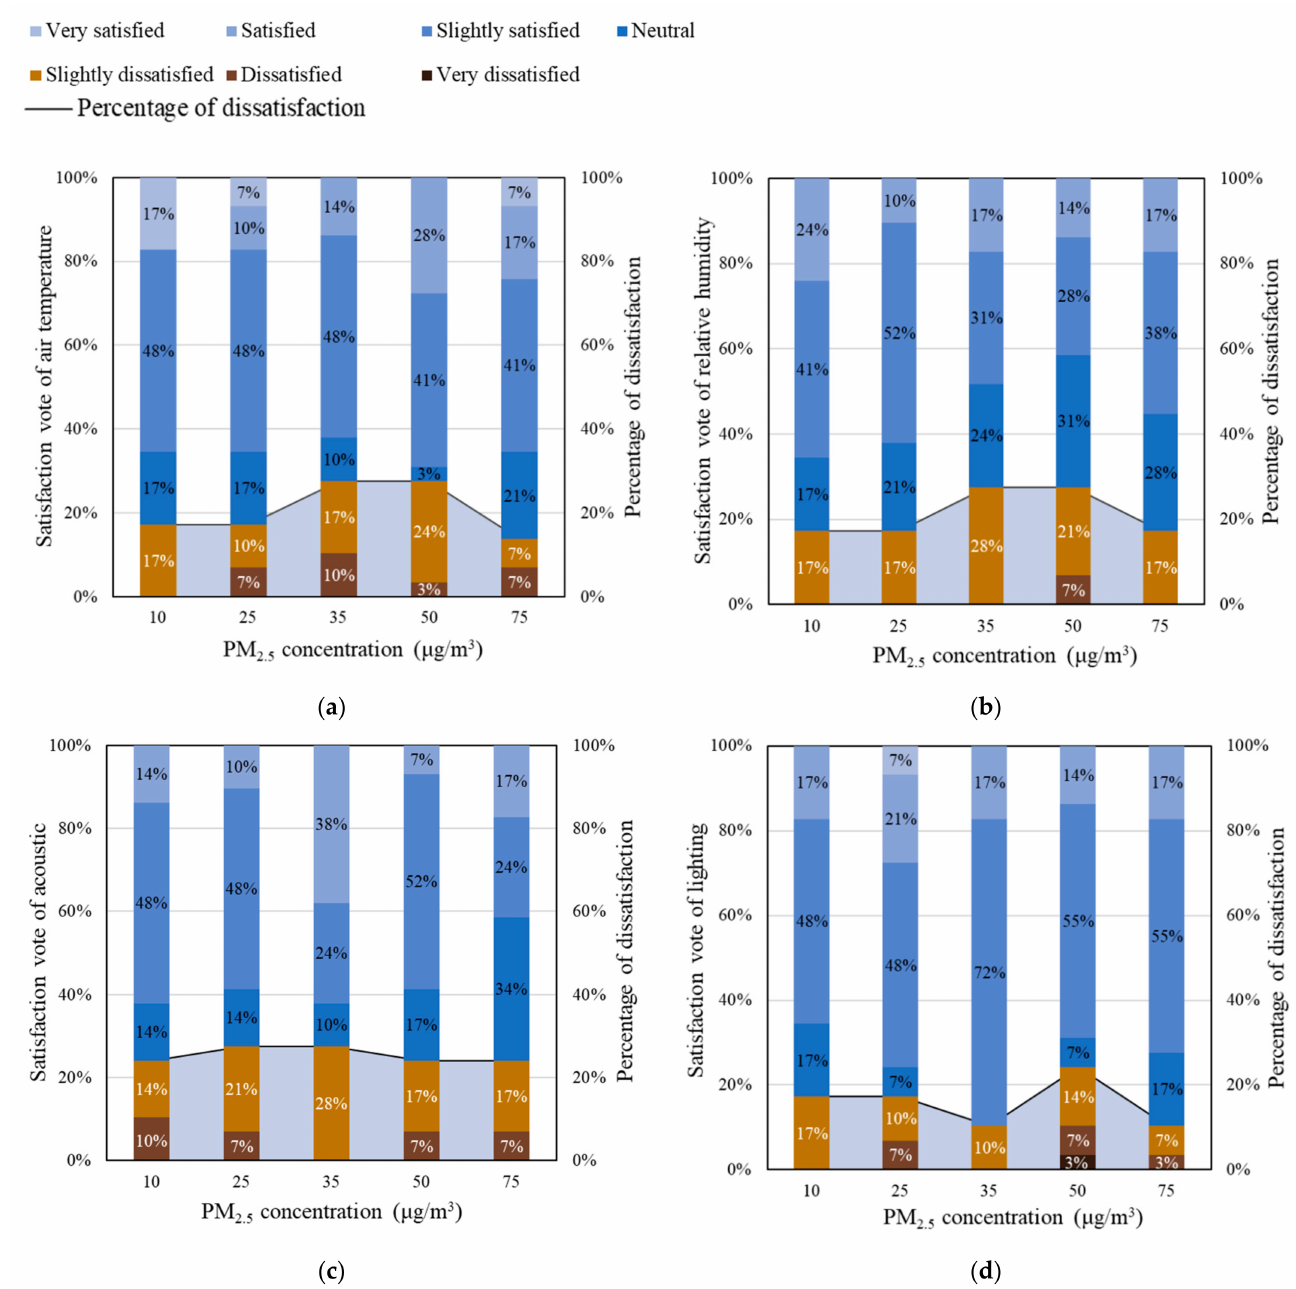
Figure 4. Distribution of Satisfaction vote and percentage of dissatisfaction of indoor environmental factors. The dissatisfaction caused by high PM 2.5 concentrations also contributes to the decline in occupants’ satisfaction with the overall indoor environment (Figure 6). When the PM 2.5 concentration rose from 10 to 75 µ g/m 3 , the overall indoor environmental dissatisfaction rate increased from 17% to 41%. According to Figure 5, each 1% increment in the indoor air quality dissatisfaction would result in a 0.5% rise in the overall environment dissatisfied rate. The PM 2.5 concentration has a remarkable impact on satisfaction vote towards the overall